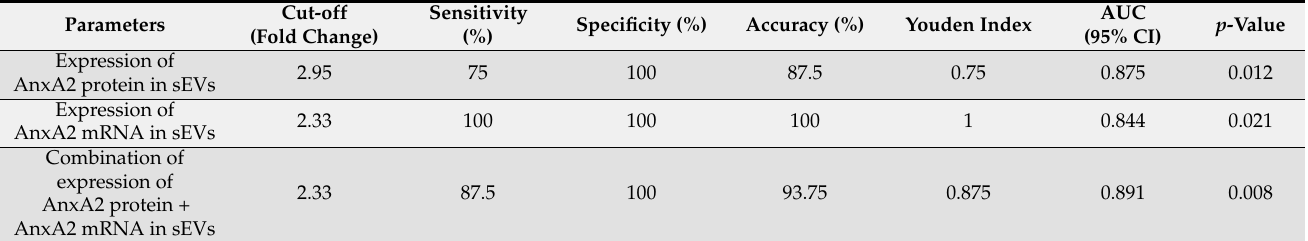
Table 2. Details of the cut-offs, sensitivity, specificity, accuracy, Youden’s Index, Area Under Curve values, and p -values of AnxA2 protein or mRNA derived from sEVs as a biomarker alone or in combination for neoadjuvant chemotherapy response in TNBC.